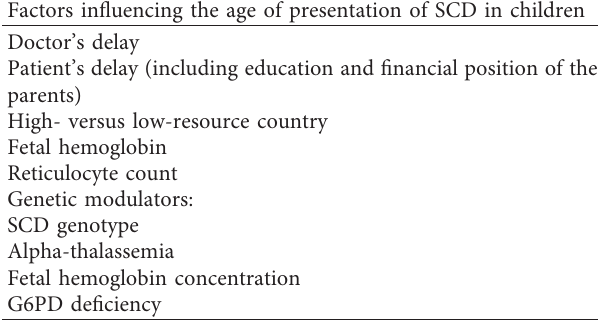
Table 1: Factors influencing the age of presentation of SCD in children. Factors influencing the age of presentation of SCD in children Doctor’s delay Patient’s delay (including education and financial position of the